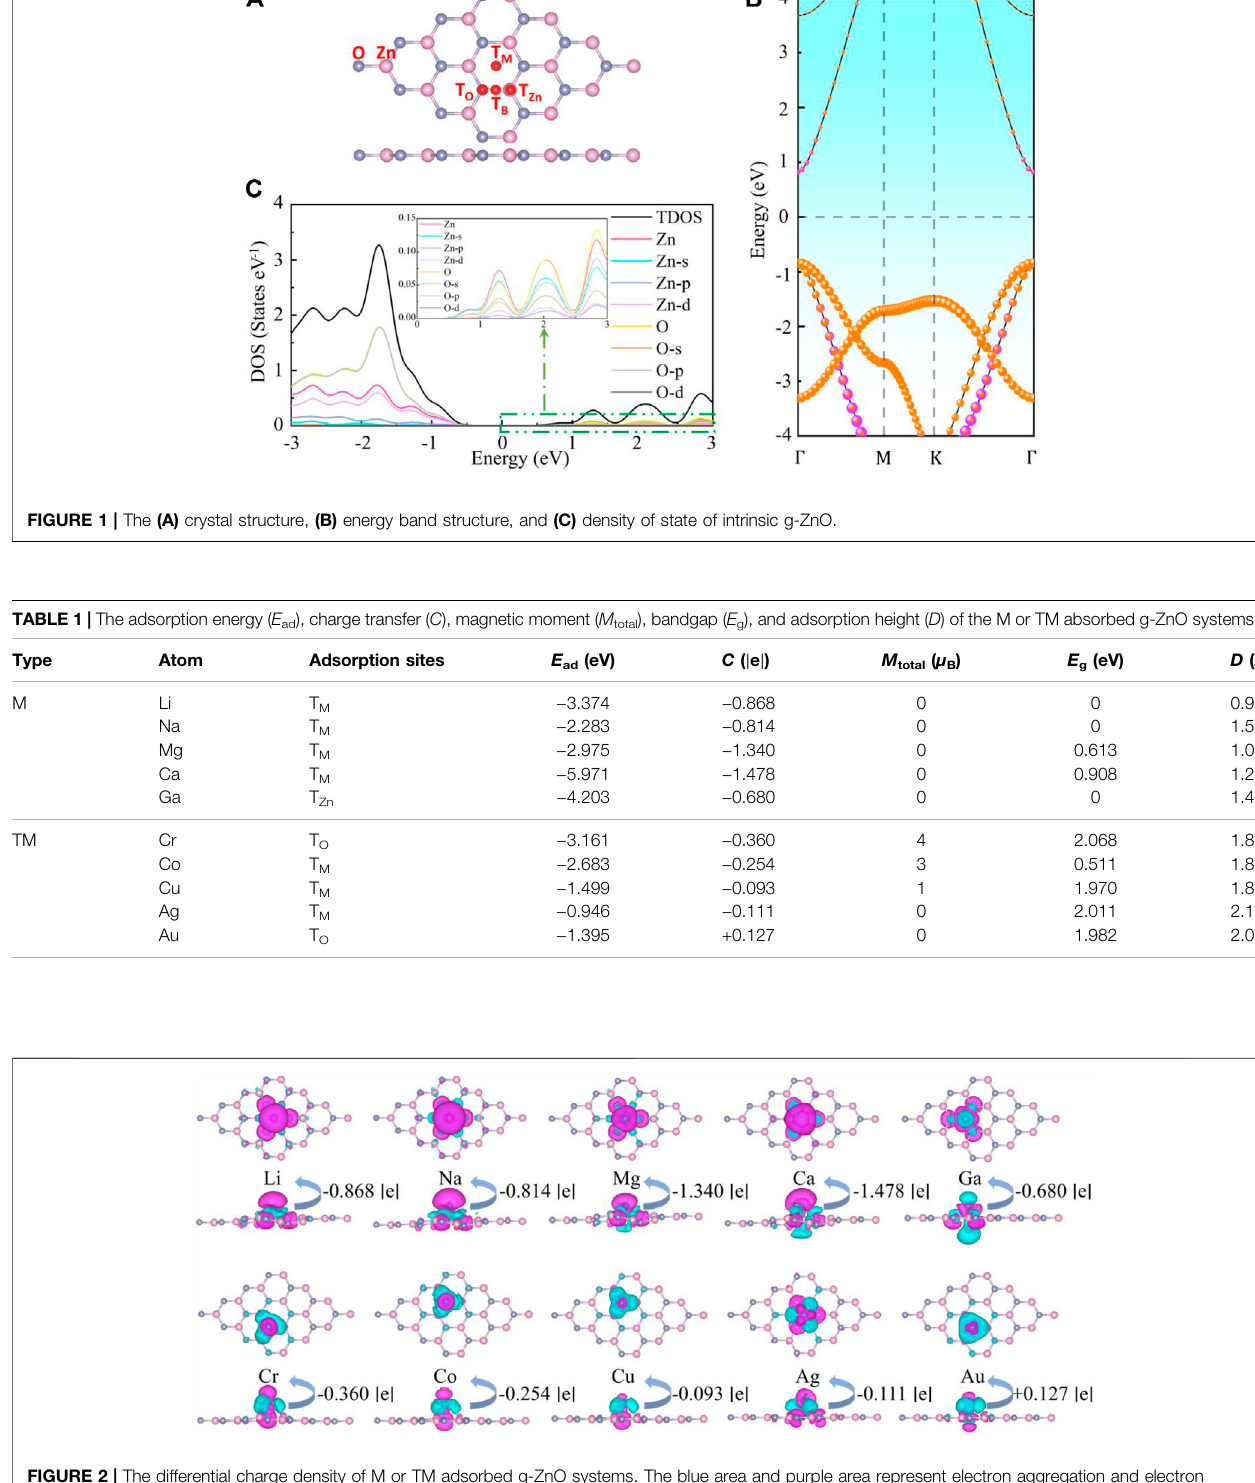
Frontiers in Chemistry |